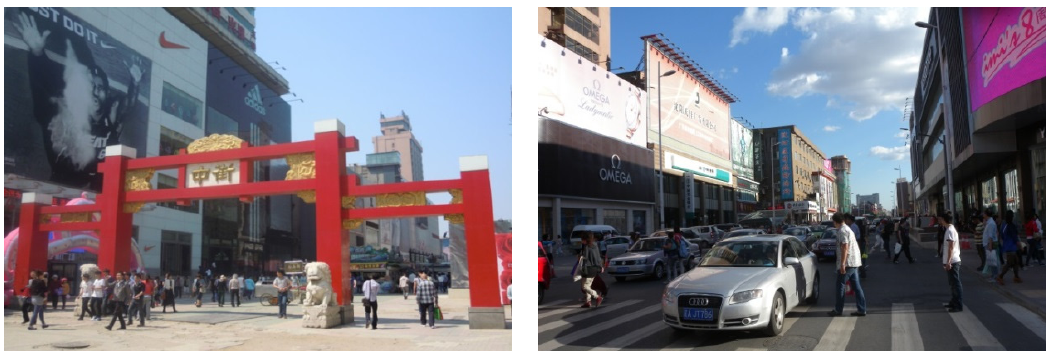
Figure 1. Location of Shenyang city and Zhongjie District in Liaoning Province, China.